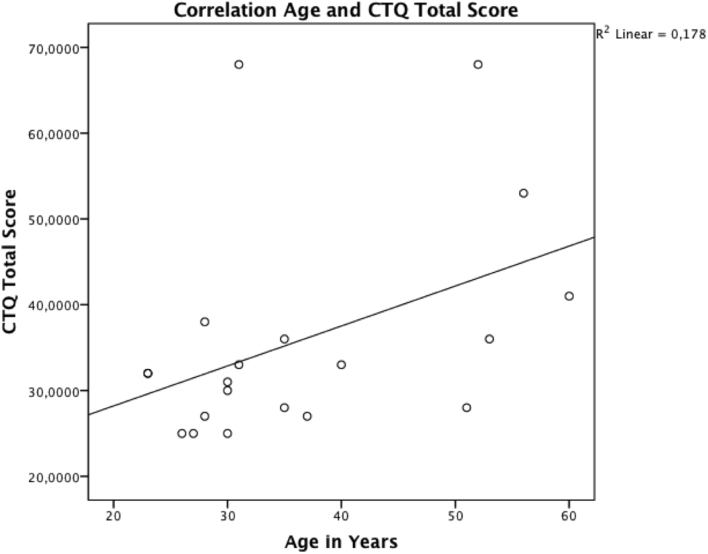
Scatterplot 1: Correlation between Age and CTQ Total Score.